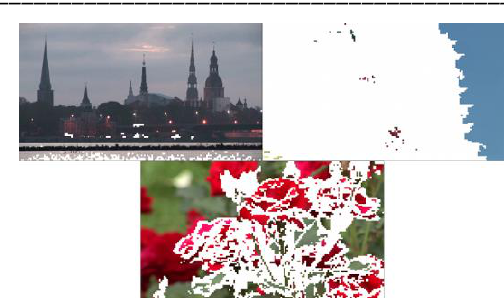
Fig. 6. Example of regions with motion detected (coloured white).